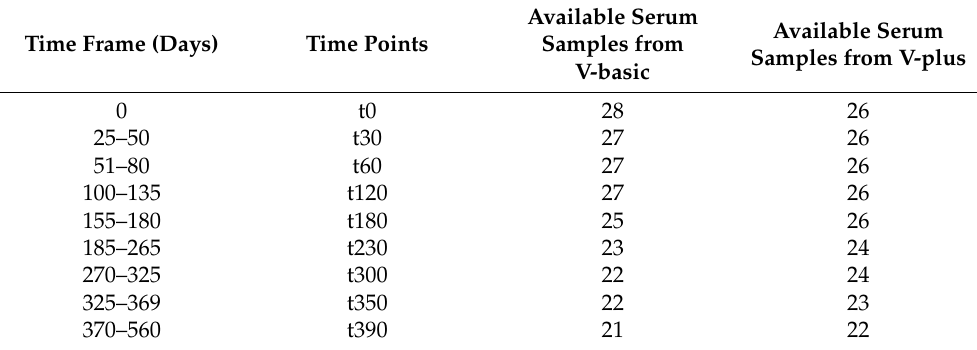
Table 1. Allocation of time frames in the observational period in days and categorization to descriptive time points used in the further